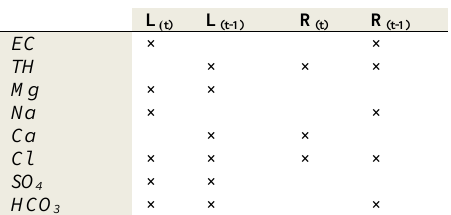
Table 2. Best input combinations for each chemical parameter.